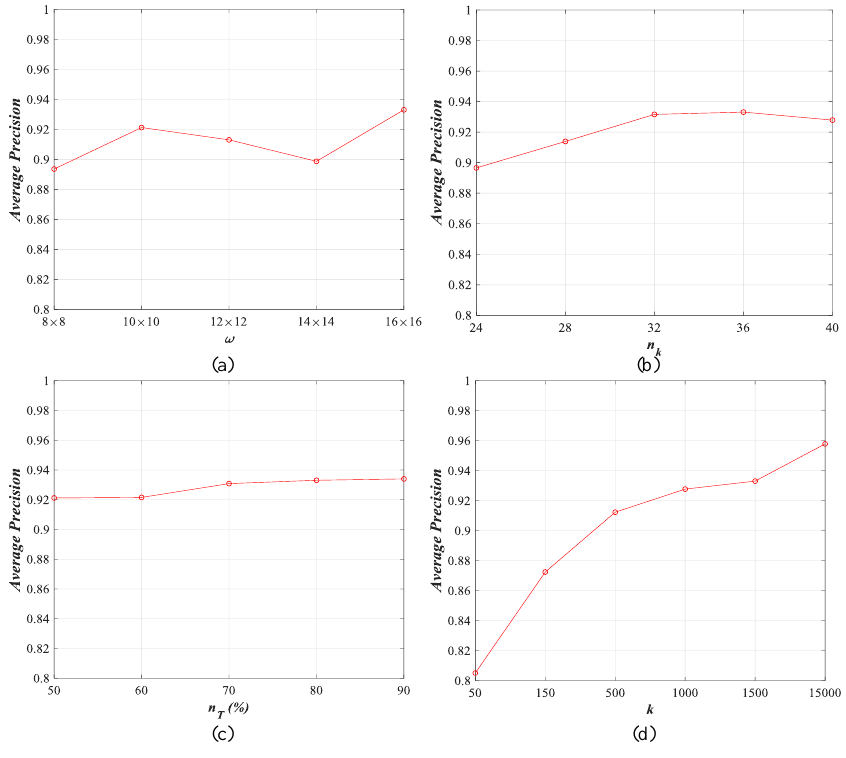
Figure 24. Influence of different parameters for ImgDB2. ( a ) ω ; ( b ) n k ; ( c ) n T ; ( d ) k .